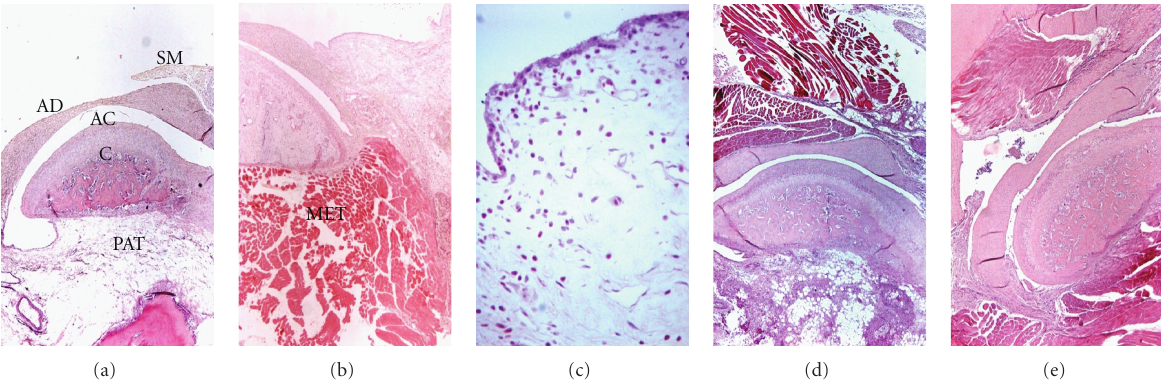
Figure 3: Photomicrographs of the histopathological analysis of TMJ and periarticular tissues. Photomicrographs of TMJ and periarticular tissues of nontreated (a, b, c) and L-NAME 100mg/kg or 1400W 1mg/kg treated animals (d, e). (a) Normal group TMJ (40x). (b) Arthritic rats, TMJ induced by zymosan 2mg (40x) showing inflammatory cell influx in the synovial membrane, periarticular tissue, musculoskeletal tissue, and synovial membrane thickness. (c) Synovial tissue of arthritic rats injected with zymosan 2 mg (400x) showing edema and inflammatory cell influx with polymorphonuclear predominance. (d) TMJ of arthritic rats injected with zymosan 2 mg and treated with